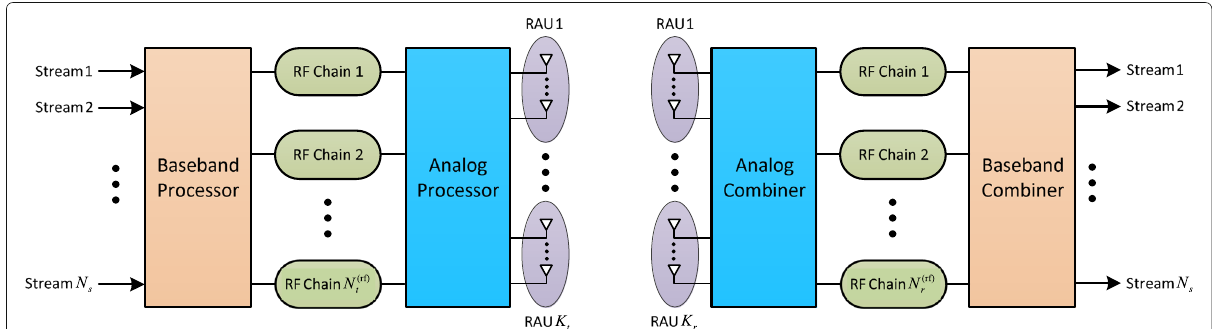
Fig. 1 Block diagram of a mmWave massive MIMO system with distributed antenna arrays